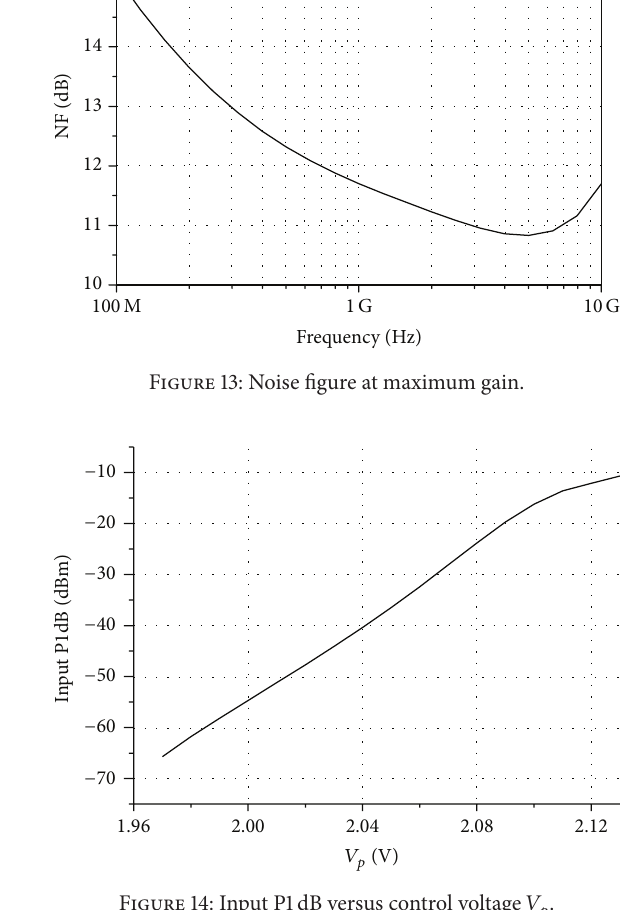
Figure 14: Input P1dB versus control voltage 𝑉 𝑝